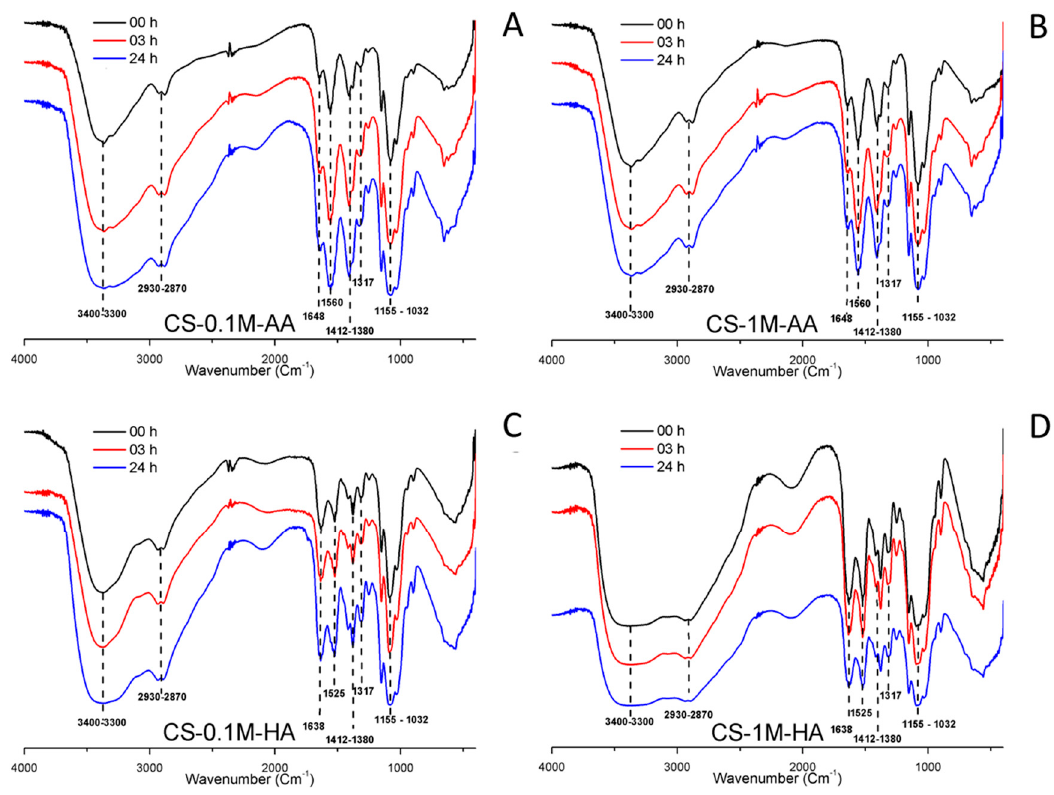
Figure 6. FT-IR spectra of chitosan samples stored at different time instants at 80 °C. ( A ), CS-0.1M-AA; ( B ), CS-1M-AA; ( C ), CS-0.1M-HA ; ( D ), CS-1M-HA.